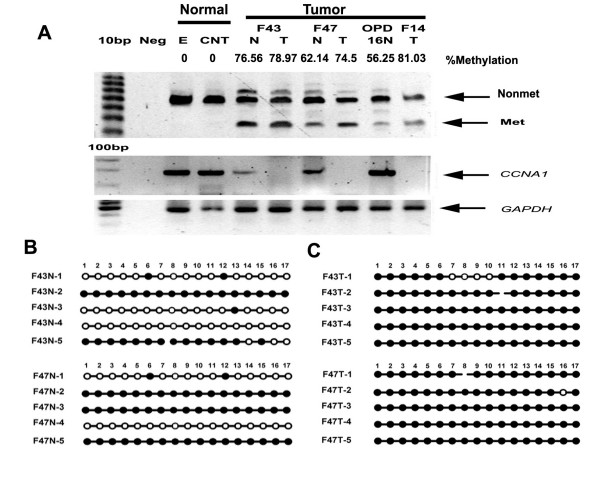
CCNA1 methylation and expression in microdissected cervical tissues. (A) Duplex MSP and CCNA1 PCR; E and CNT are epithelium and connective tissue cells from normal cervix; N and T are adjacent histological normal and cancer cervical epithelium from CC, respectively. Arrows indicate non-methylated, methylated, CCNA1 cDNA and GAPDH cDNA, respectively. (B) Bisulfite sequencing at the CCNA1 promoter, with circles denoting the methylation status of each selected clone. Black and white circles are methylated CG dinucleotides, and non-methylated CpG dinucleotides and TG dinucleotides, respectively.